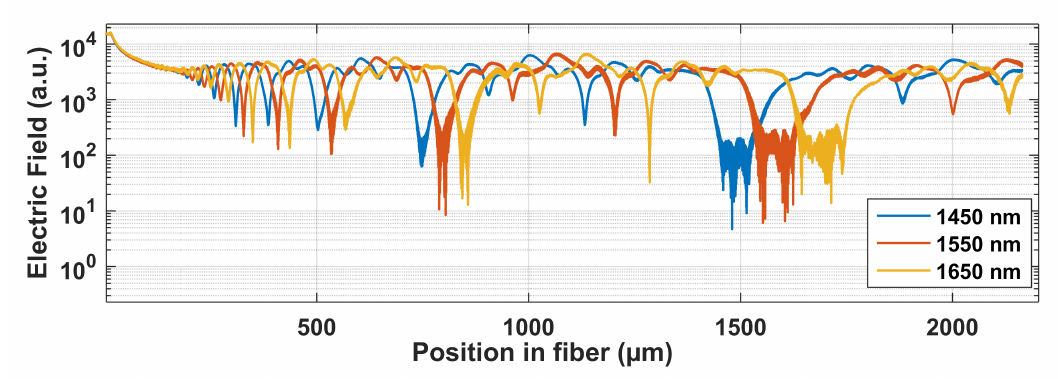
Figure 3. Electric field along a center line running through the